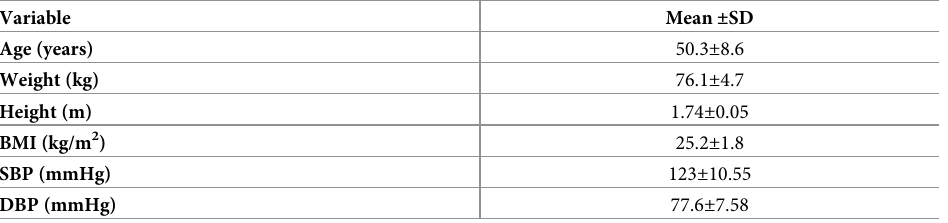
Table 1. Clinical and anthropometrical characteristics of tuberculoid leprosy patients.